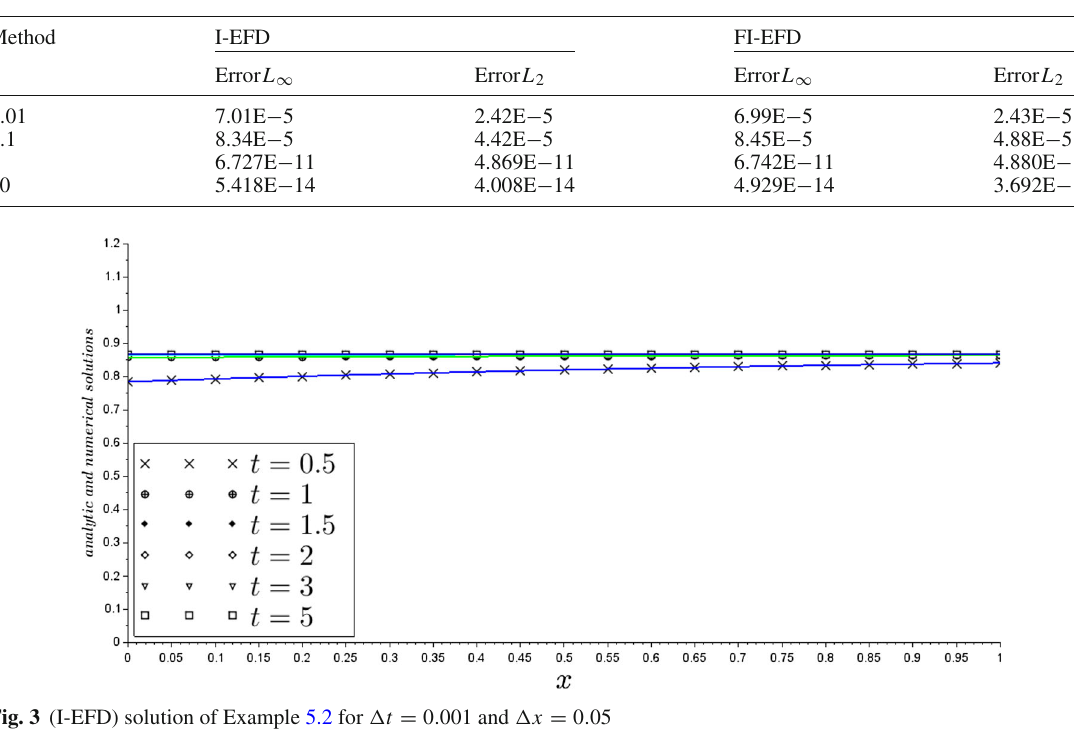
Table 6 L ∞ and L 2 errors of Example 5.2 for (cid:2) x = 0 . 05 and (cid:2) t = 10 − 4